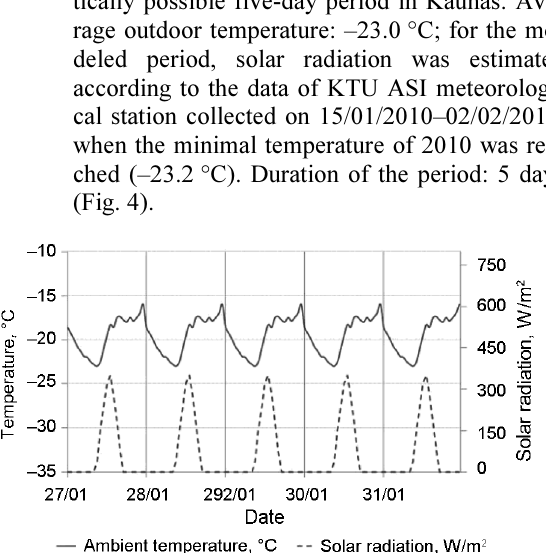
Fig. 4. The coldest theoretically possible five-day period in